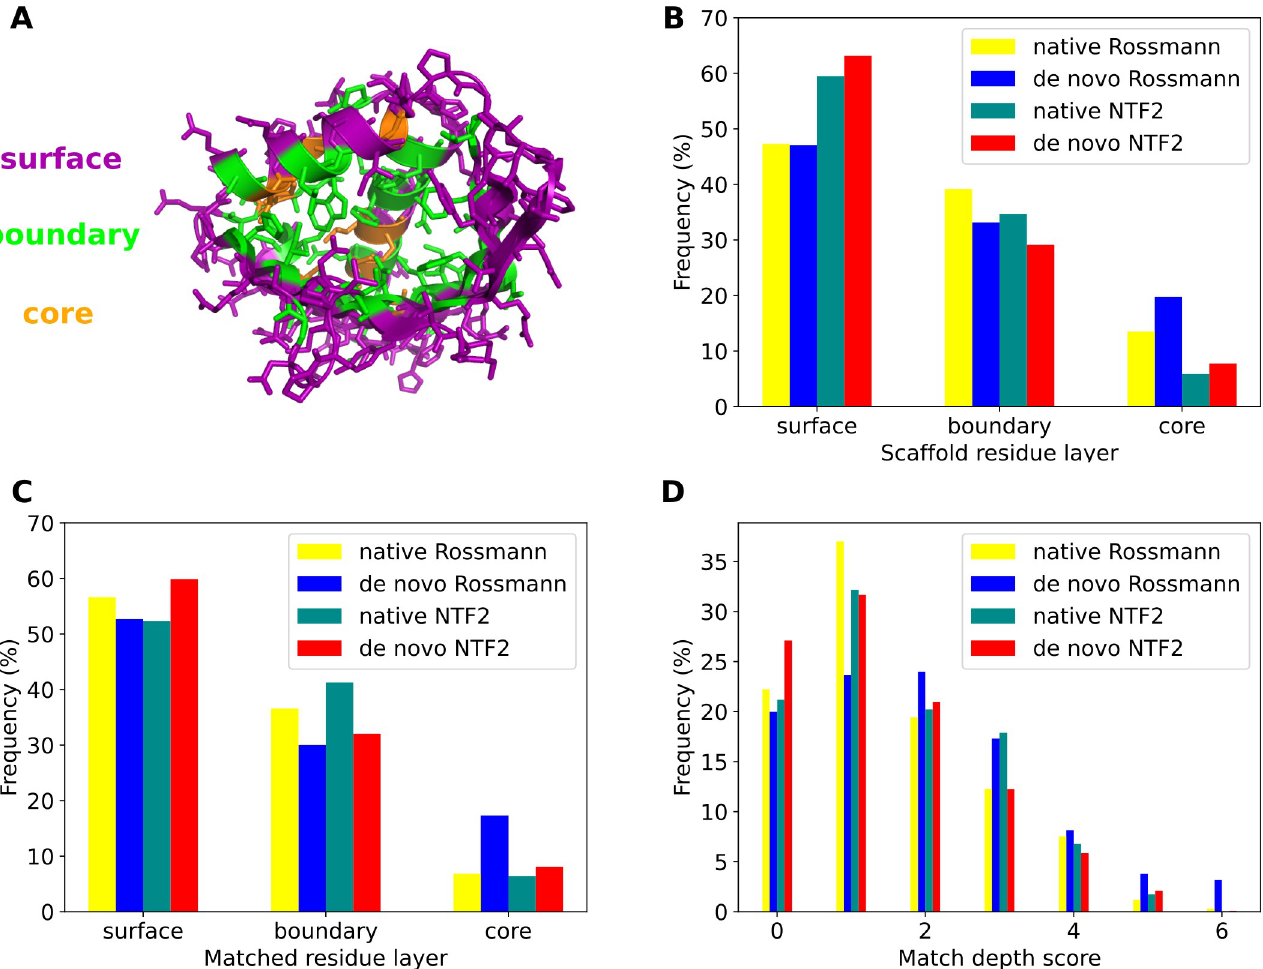
Fig 4. Ligand binding sites are matched to all layers of scaffolds. A. An example of scaffold residue layers assigned to a scaffold (PDB:3FH1) from the native NTF2 fold family by the Rosetta Layer residue selector. The surface, boundary and core layers are colored in purple, green and orange, respectively. B. Distributions of residue layers in different scaffold libraries. C. Distributions of residue layers of binding sites matched to different scaffold libraries. D. Distributions of binding site depth scores matched to different scaffold libraries.